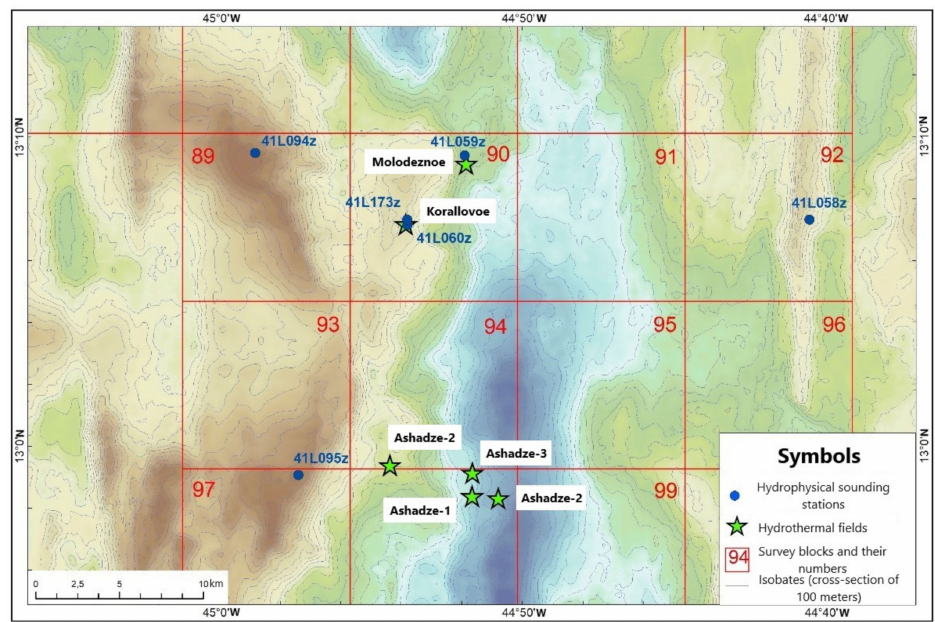
Figure 7. Position of CTD sounding stations (star), Molodezhnoye and Koralovoye fields.